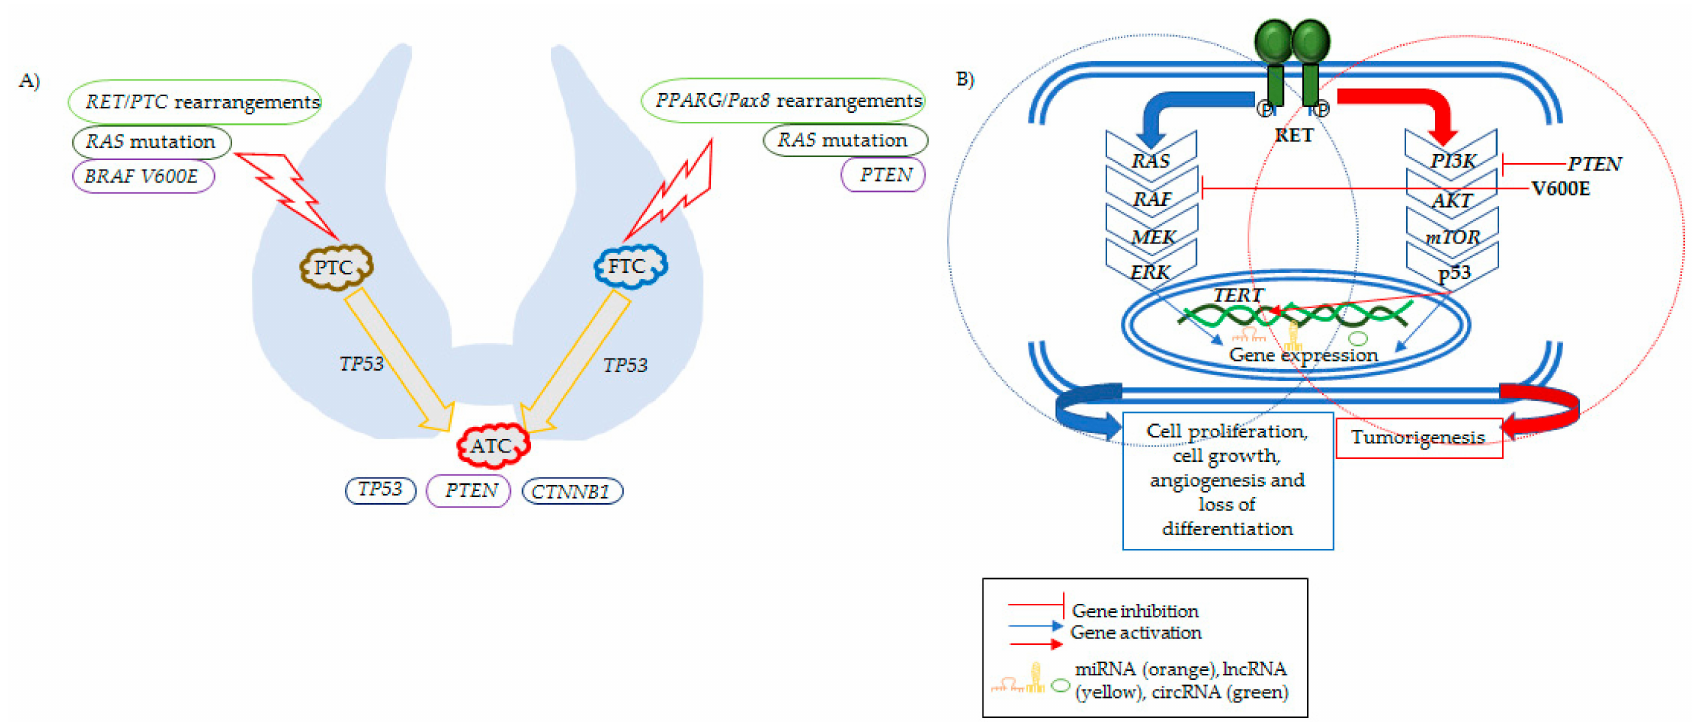
Figure 1. Progression of thyroid cancer and the main genetic alterations involved in such process. ( A ) Picture depicting thyroid cancer hystotypes and their causative genetic events. PTCs present BRAF (V600E substitution), RAS mutations, and / or RET / PTC rearrangements. FTCs display PPARc / Pax8 rearrangements, RAS mutations, and PTEN inactivating mutations or deletions. ATCs are characterized by PTEN and CTNNB1 mutations and p53 inactivation. ( B ) Schema shows the key molecular signaling pathways involved in thyroid cancer. On the left (inside the circle with dashed blue line): MAPK pathway, which is activated in most thyroid cancers after a mutational event. Once thyroid cancer development is initiated, gene expression is altered, evoking cell proliferation, cell growth, angiogenesis, and loss of di ff erentiation. On the right (inside the circle with dashed red line): pathways altered in advanced thyroid cancers, which promote tumor progression. This includes the PI3K–mTOR pathway, the p53 tumor suppressor, and alterations in the promoter for TERT. miRNAs, lncRNAs and circRNAs are also represented inside the nucleus as genetic players in thyroid cancer